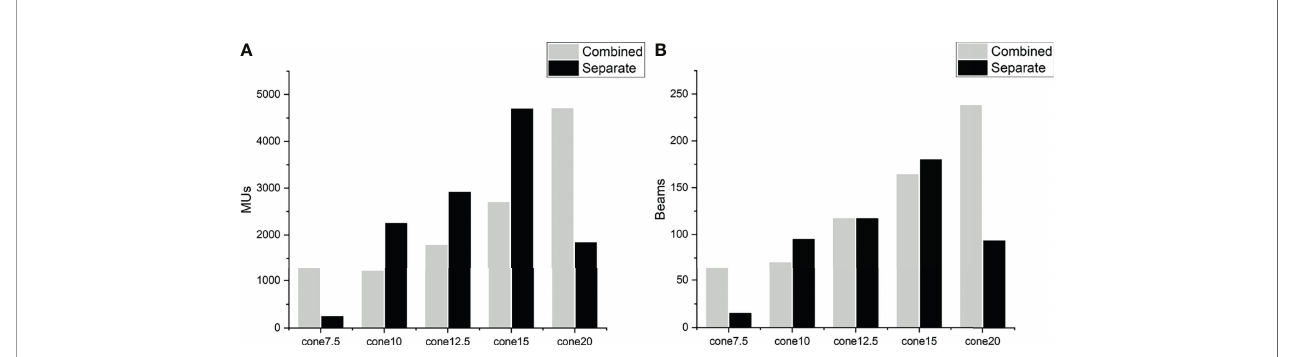
FIGURE 2 | Comparison of MUs (A) and beams (B) in different optimization